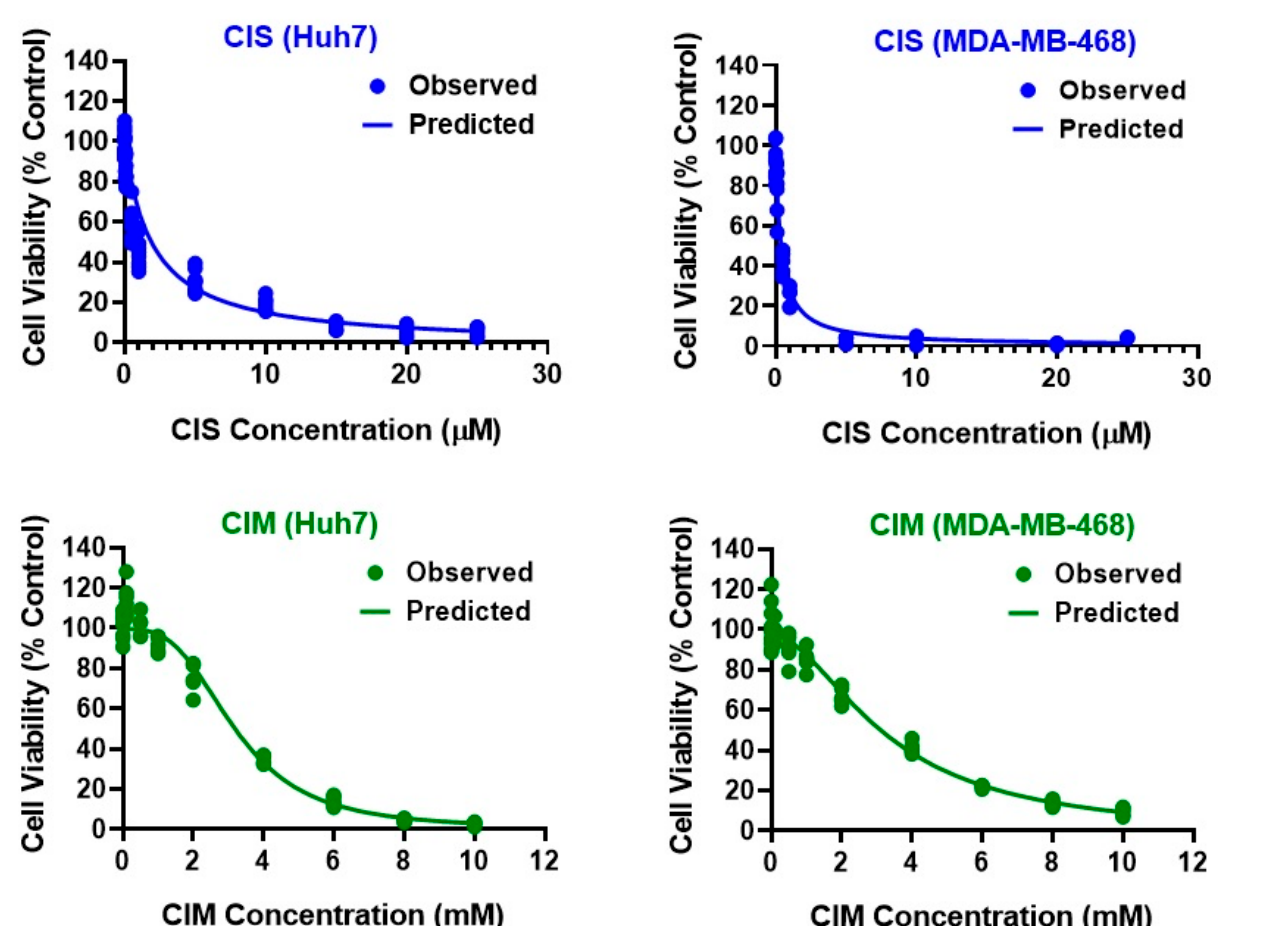
Figure 1. Concentration-response curves for CIS ( top , blue) and CIM ( bottom ; green) as single agents in Huh7 ( left ) and MDA-MB-468 ( right ) cancer cell lines. Observed data are represented by solid circles while the smooth lines are model fittings.